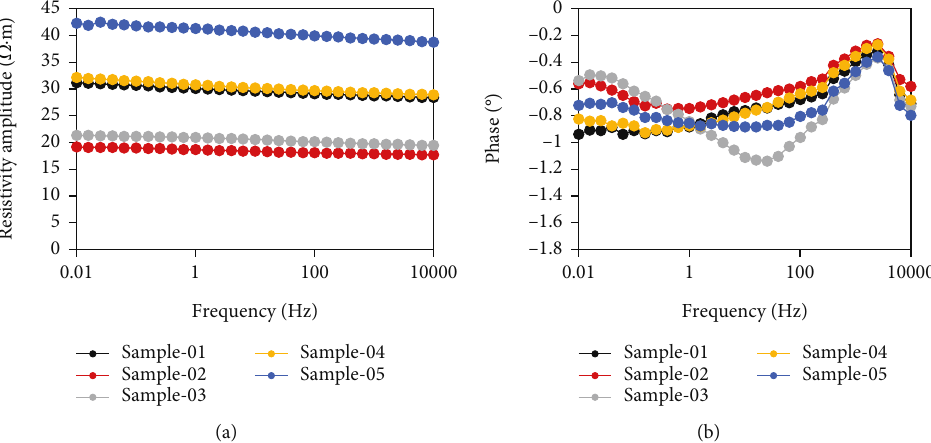
Figure 4: Amplitude and phase of complex resistivity of sandstone samples under normal temperature and pressure conditions: (a) complex resistivity amplitude curve and (b) complex resistivity phase